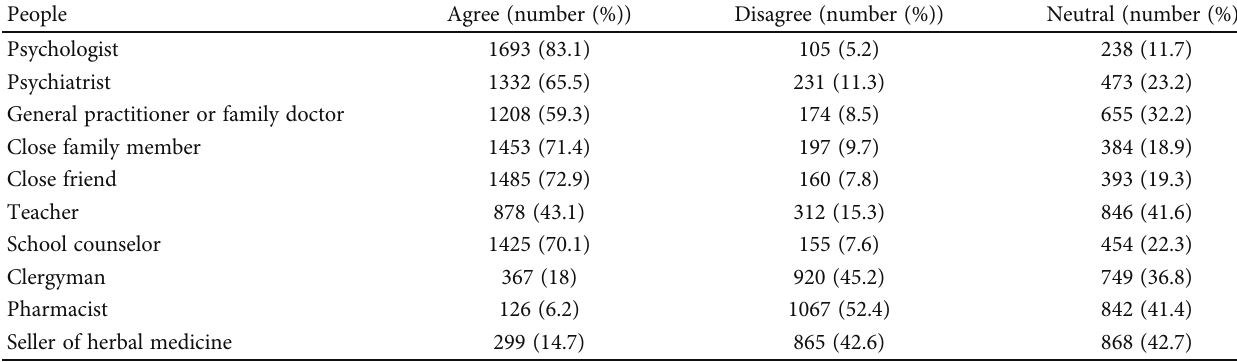
Table 1: Adolescent ’ s beliefs about people who could possibly help the vignette.